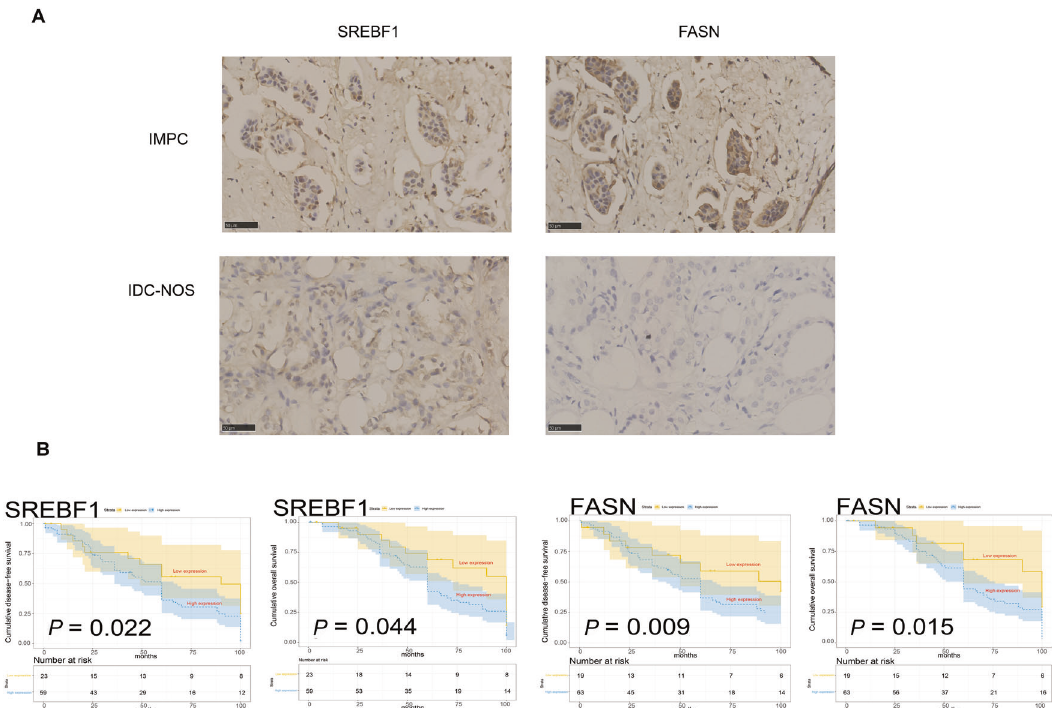
Fig. 6 Clinical outcomes associated with the expression of the SREBF1 and FASN proteins in 82 patients with IMPC and 80 with IDC-NOS. A Images of immunohistochemical staining for SREBF1 and FASN in patients with IMPC ( n = 82) and IDC-NOS ( n = 80). The upper panel shows high expression of SREBF1 and FASN in patients with IMPC; the lower panel shows low expression of the SREBF1 and FASN proteins in patients with IDC-NOS, x400 magni fi cation. B The association of SREBF1 and FASN protein expression with disease-free survival (DFS) and overall survival (OS). The light panel shows SREBF1, and the right panel shows FASN, with patients with IMPC strati fi ed by high and low protein expression. Log-rank test, two-sided. The P values for DFS of SREBF1 and FASN were 0.022, and 0.009, respectively; the P values for OS of SREBF1 and FASN were 0.044 and 0.015, respectively. P < 0.05 was considered to indicate statistical signi fi